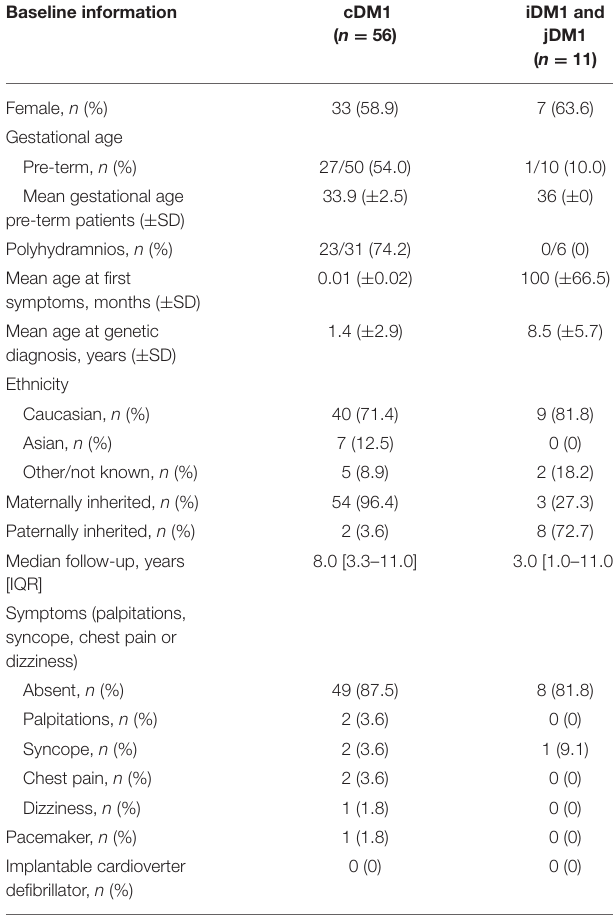
TABLE 1 | Baseline characteristics of patients with DM1. Baseline information